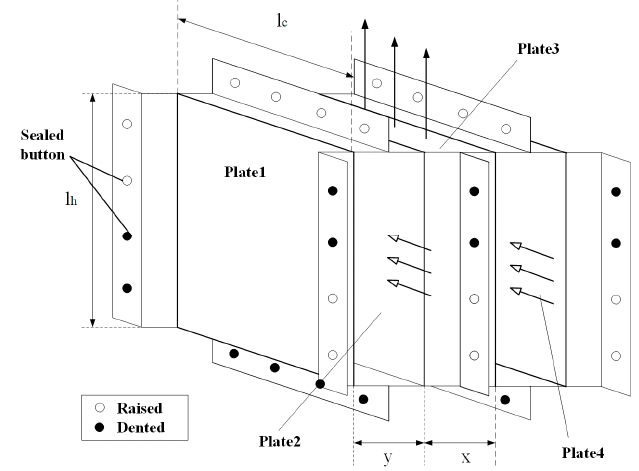
Figure 5. Schematic diagram of the heat exchanger unit.